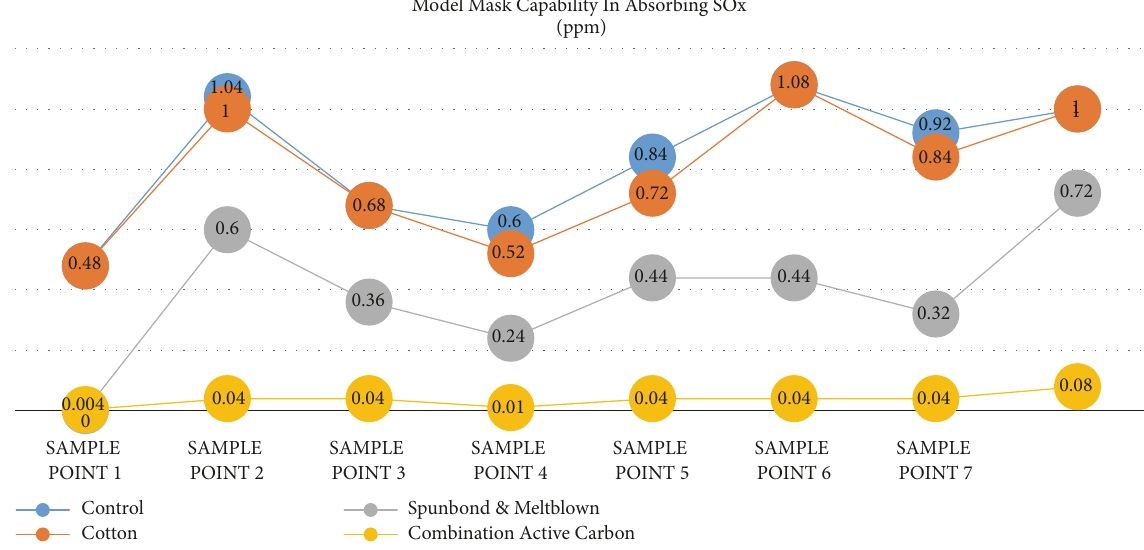
Figure 2: Various types of masks in absorbing